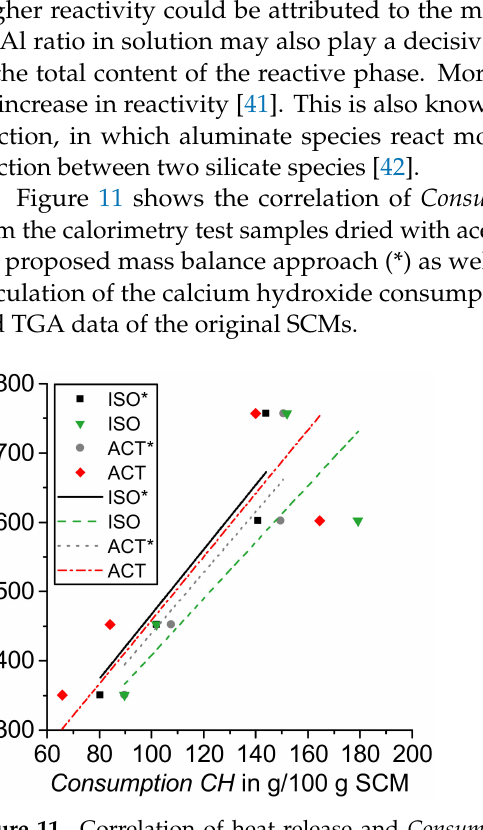
Figure 11. Correlation of heat release and Consumption CH (acetone and isopropanol) — Used abbreviations are outlined in Table